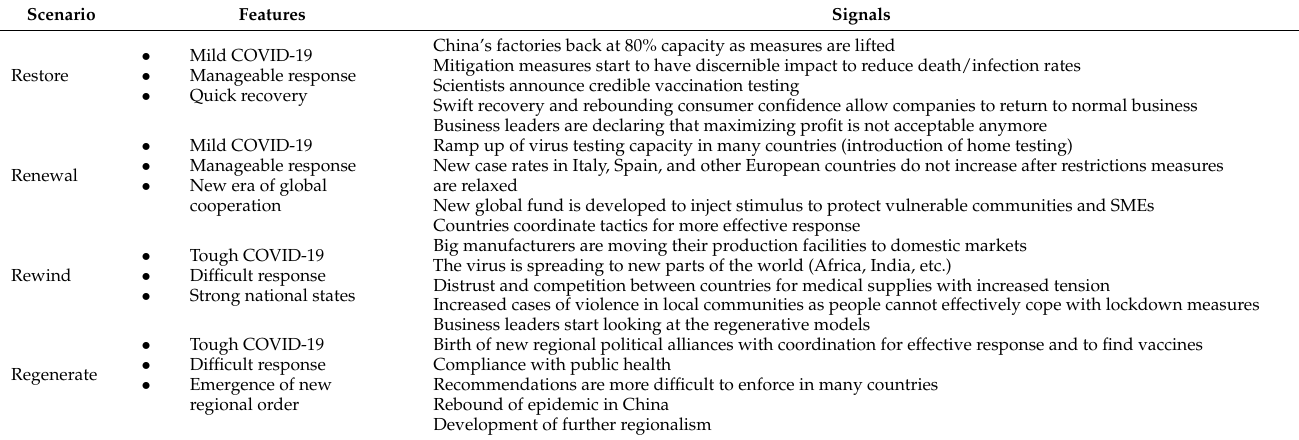
Table 3. Four plausible scenarios of the future of the global energy sector by WEC,